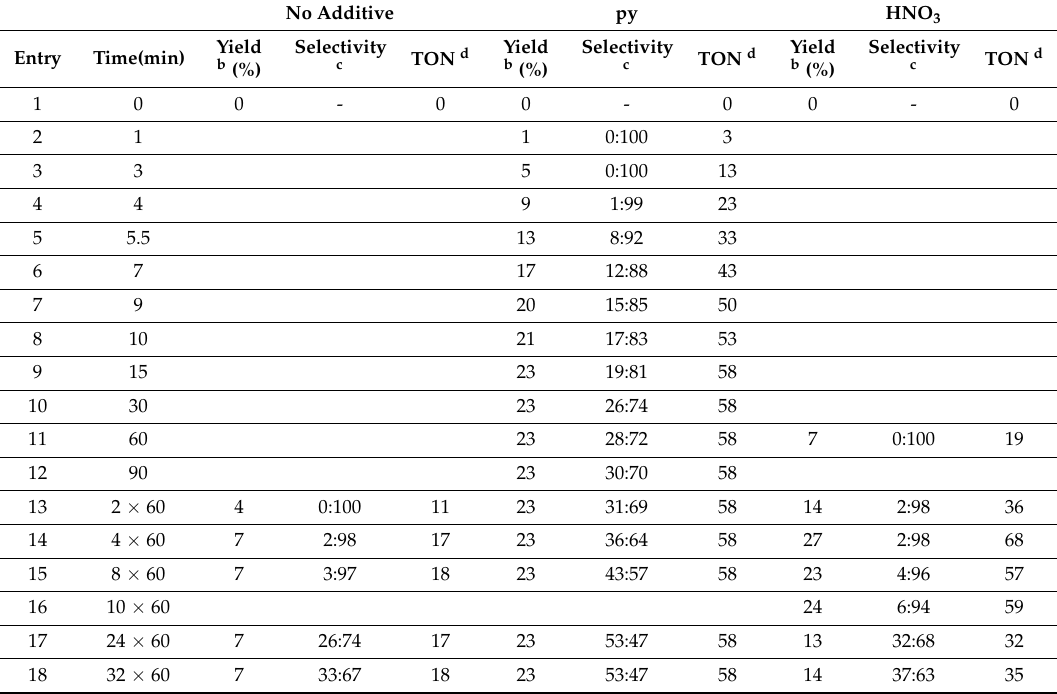
Table 5. Effect of the presence of an additive in the oxidation of cyclooctane catalyzed by 4 a .